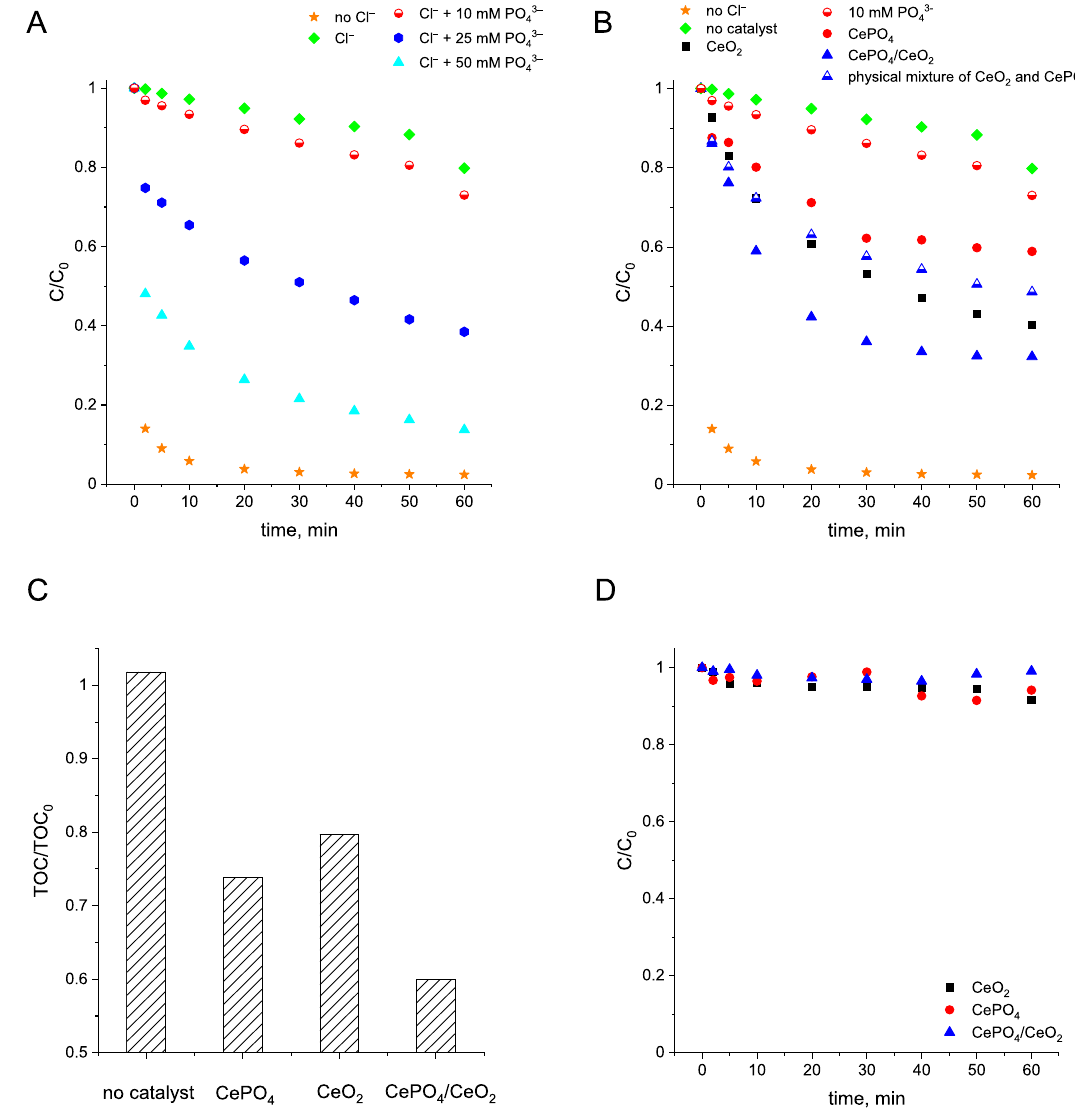
Figure 5. ( A ) Influence of phosphate concentration on the efficiency of benzoic acid degradation during ozonation in the presence of chloride ions; ( B ) Results of benzoic acid degradation during ozonation processes in the presence of chlorides and heterogeneous catalysts synthesized in this study; ( C ) Total organic carbon removal after 60 min of ozonation processes in the presence of chlorides and catalysts. ( D ) Removal of benzoic acid from reaction mixtures resulting from adsorption of BA on the catalyst surfaces in the absence of ozone; Reaction conditions: 200 mL of BA solution (24 µM), initial ozone concentration: 120 µM, initial pH: 2.5, concentration of chloride ions: 3.22 mM, catalyst loading: 0.2 g/L, room temperature. The physical mixture of CeO 2 and CePO 4 consisted of 20 mg of cerium dioxide and 20 mg of cerium(III)